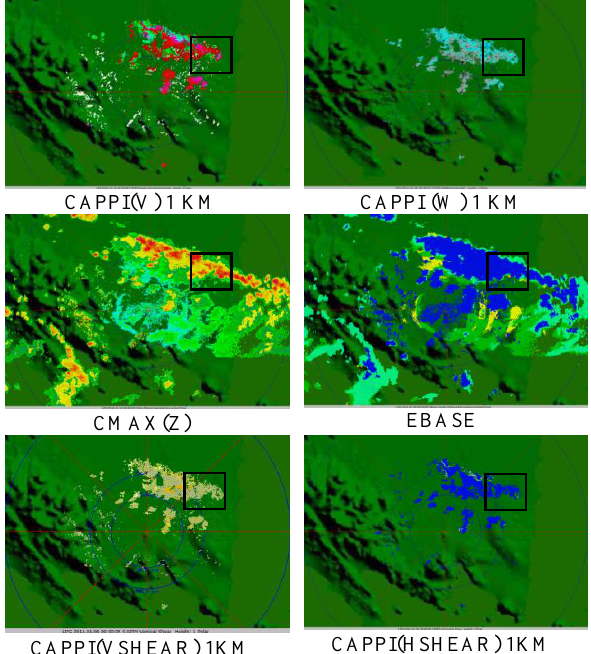
Figure 2. Radar product at whirl wind occurence in